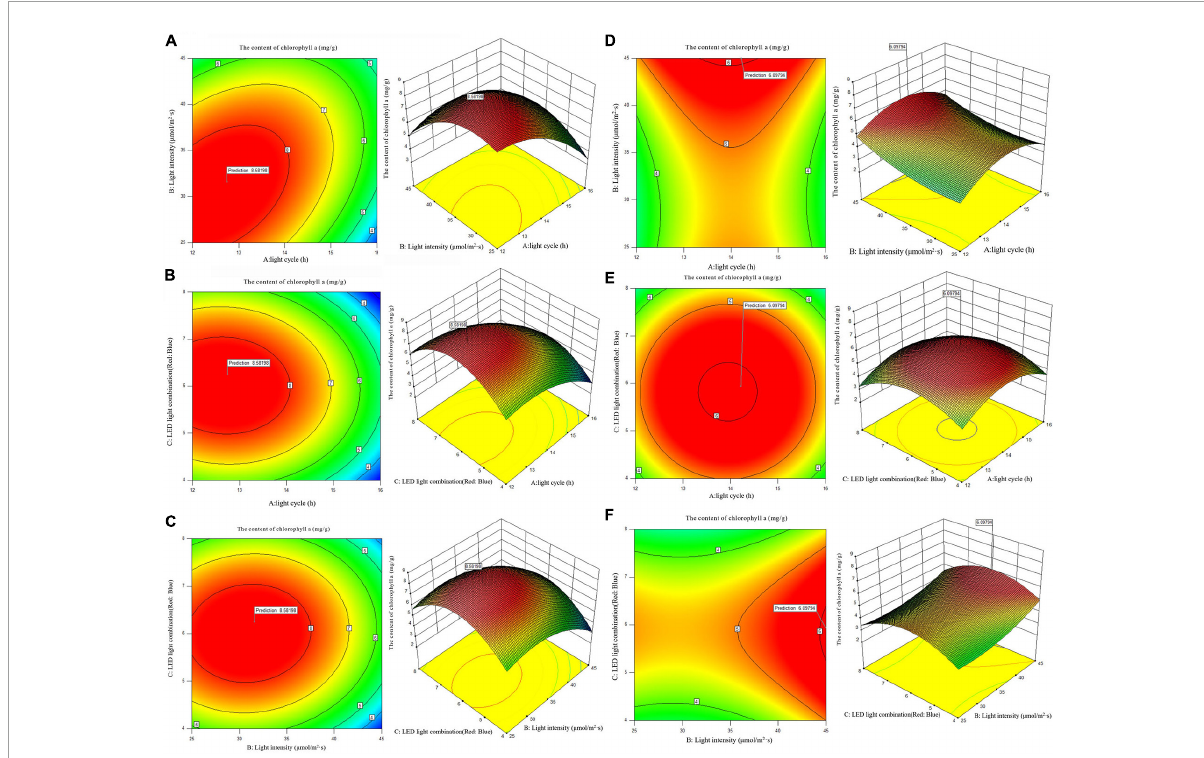
FIGURE3 2D contour diagram and 3D surface diagram of chlorophyll a content of Arthrospira platensis OUC623 and A. platensis OUC793. (A) Contour diagram and response surface diagram of chlorophyll a content of 623 with light time (12, 14, and 16 h) and light intensity (25, 35, and 45 µ mol/m 2 s) under the light of red6:blue 1. (B) Contour diagram and response surface diagram of chlorophyll a content of 623 with light time (12, 14, and 16 h) and red and blue light combination (red: blue = 4:1, 6:1, 8:1) under light intensity of 35 µ mol/m 2 s. (C) Contour diagram and response surface diagram of chlorophyll a content of 623 with red and blue light combination (red: blue = 4:1, 6:1, 8:1) and light intensity (25, 35, and 45 µ mol/m 2 s) under the light cycle of L14:D10. (D) Contour diagram and response surface diagram of chlorophyll a content of 793 with light time (12, 14, and 16 h) and light intensity (25, 35, and 45 µ mol/m 2 s) under the light of red6:blue 1. (E) Contour diagram and response surface diagram of chlorophyll a content of 793 with light time (12, 14, and 16 h) and red and blue light combination (red: blue = 4:1, 6:1, 8:1) under light intensity of 35 µ mol/m 2 s. (F) Contour diagram and response surface diagram of chlorophyll a content of 793 with red and blue light combination (red: blue = 4:1, 6:1, 8:1)and light intensity (25, 35, and 45 µ mol/m 2 s)under the light cycle of